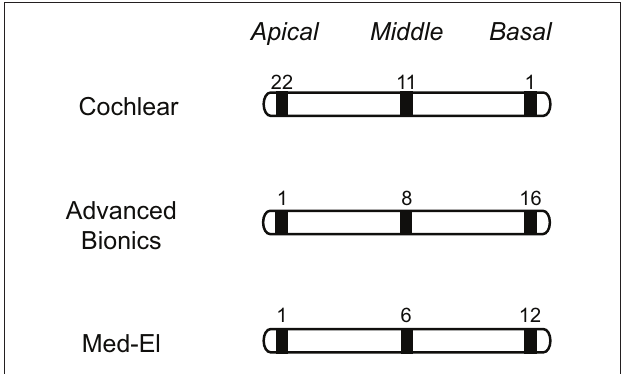
FIGURE 1 | Electrode stimulation site by condition and CI manufacturer. Diagrammatic representations of electrode arrays are presented by CI manufacturer, with the stimulated electrode number listed above the appropriate electrode (shaded in black) for apical (left), middle (center), and basal (right) stimulation